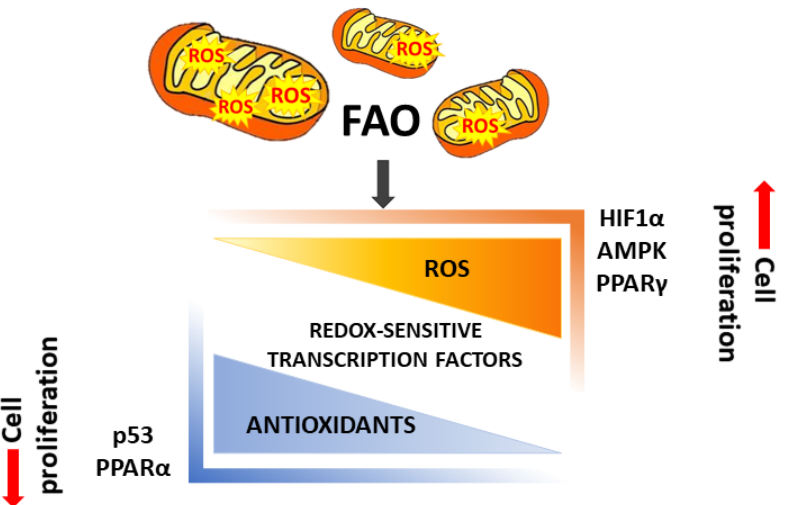
Figure 2. The balance between ROS production and elimination contributes to the regulation of tumor cell proliferation. FAO is responsible for mitochondrial ROS production, which in turn is buffered by intracellular antioxidants. Downstream of FAO, the ROS are low in tumor cells equipped with prominent antioxidant systems, whereas the ROS are high if not properly buffered. In this case, ROS are able to activate redox-sensitive transcription factors (e.g., HIF1 α , AMPK, PPAR γ ), inducing cell proliferation. Instead, more efficient antioxidant systems allow FAs to play a signaling role, activating selective transcription factors (e.g., PPAR α , p53), reducing cell proliferation.